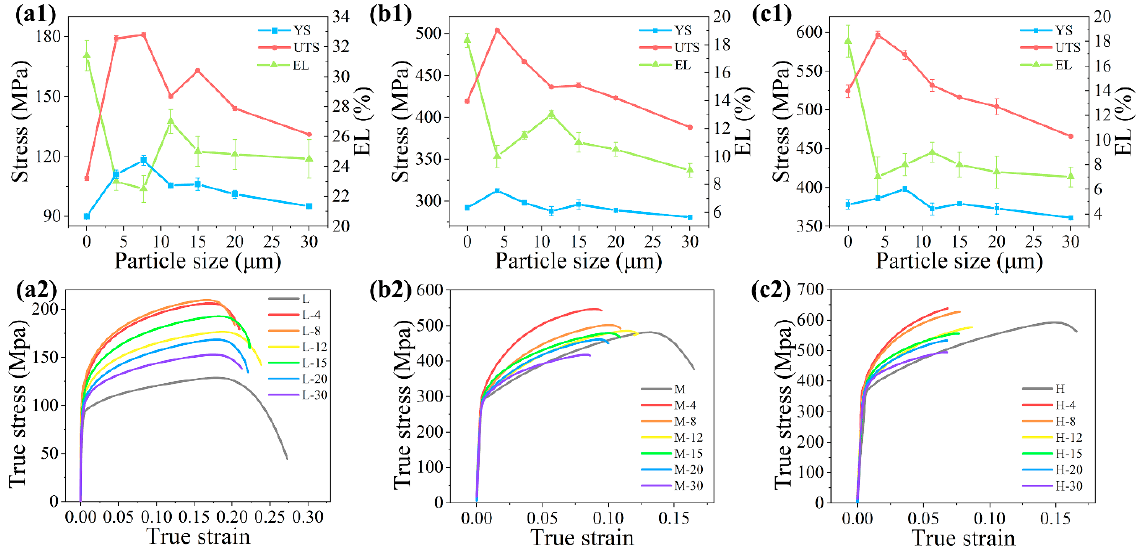
Figure 1. The ( 1 ) mechanical properties (yield strength (YS), ultimate strength (UTS), and elongation (EL)) and ( 2 ) true stress–true strain curve of the composites with ( a ) matrix L, ( b ) matrix M, and ( c ) matrix H reinforced by particle sizes of 4.1, 7.7, 11.3, 14.8, 19.6, and 29.9 μ m, separately. The 0 μ m particle size represents the unreinforced matrix.